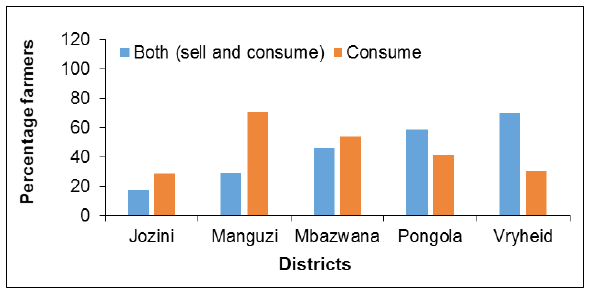
Consumption and trading of harvested homegrown maize by subsistence farmers in five districts of northern KwaZulu-Natal (chi-square: d.f.=4; p